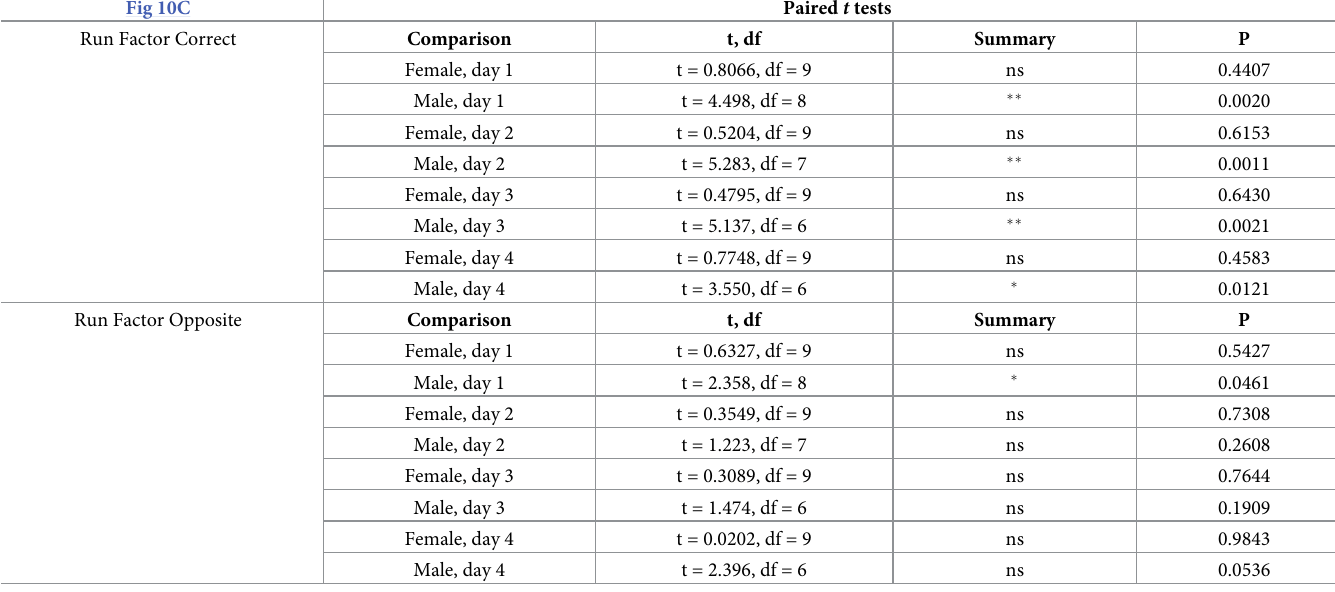
Table 17. Statistical analysis of data shown in Fig 10C for serial reversal, cohort B, Run comparison. Fig 10C Paired t